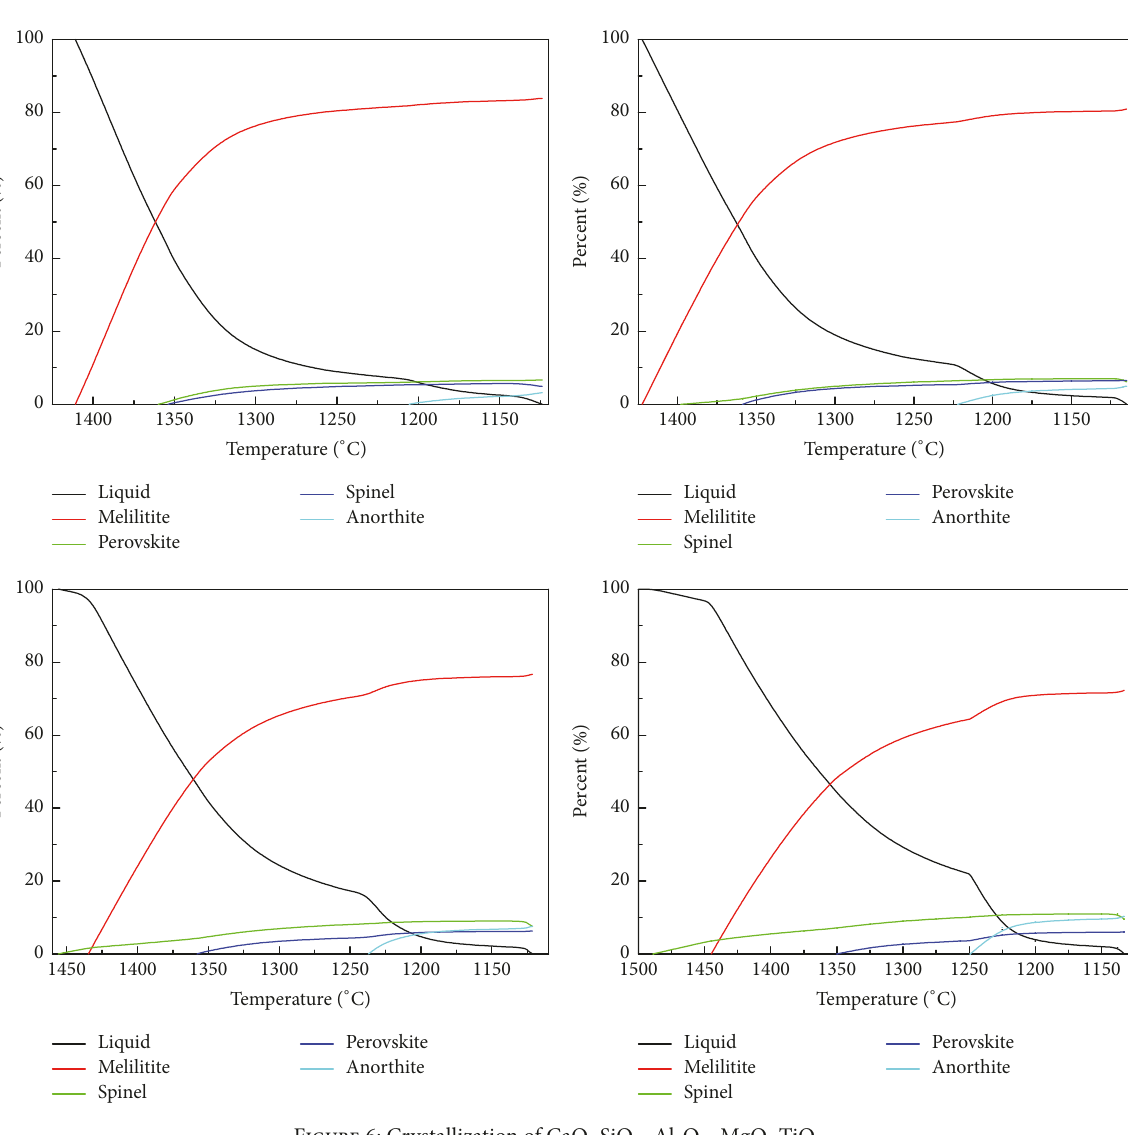
Figure 6: Crystallization of CaO–SiO 2 –Al 2 O 3 –MgO–TiO 2 .